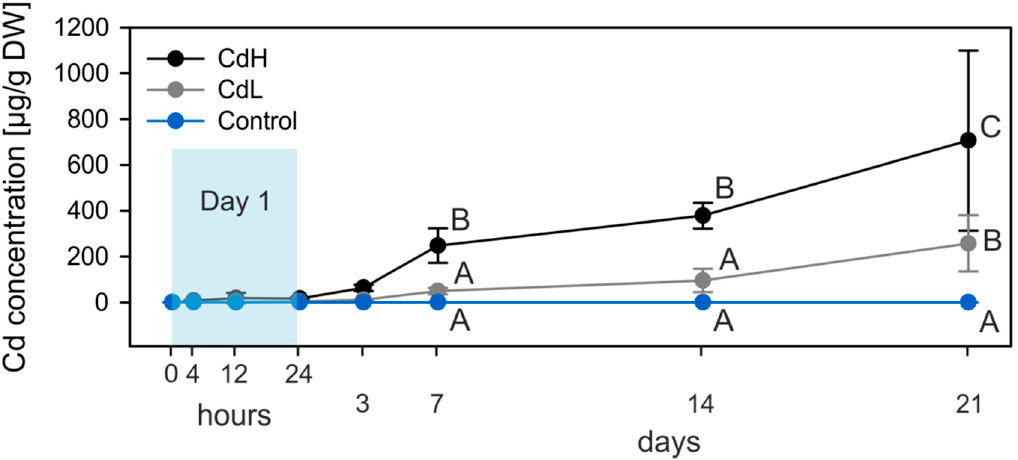
Figure 1. Cd accumulation in the digestive gland of the control (blue lines and symbols) and Cd-exposed winkles (grey line and symbols: CdL = 0.25 mg Cd /L; black line and symbols: CdH = 1 mg Cd /L). Mean values and standard deviations ( n = 4) are shown. The significance of the accumulation curves (CdL and CdH) was confirmed by ANOVA ( p ≤ 0.001). The significant differences of values between Cd-exposed and control individuals at different time points (Holm–Sidak pairwise multiple comparison, significance level 0.05) are indicated by different letters. Sampling points during the first 24 h (Day 1) are under-laid in blue.